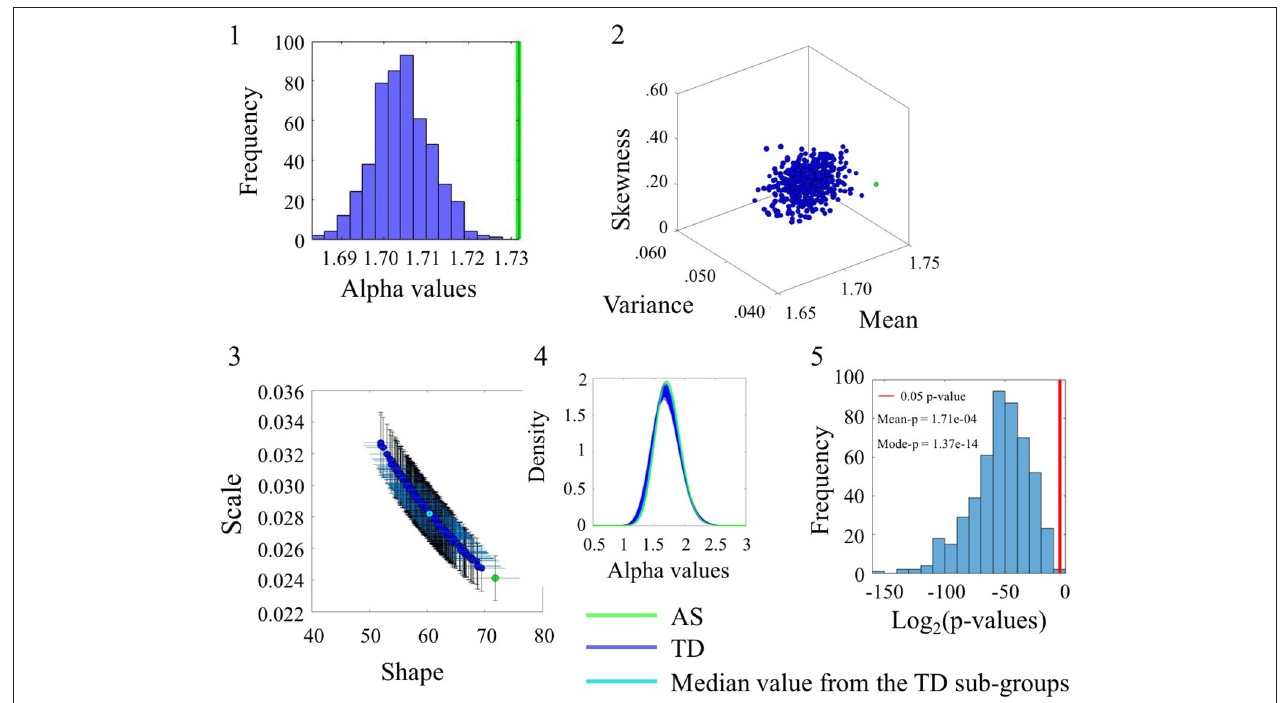
FIGURE 5 | Comparison between TD and AS groups for the Linear Speed (SR0 groups). Figure format similar to Figure 4 .